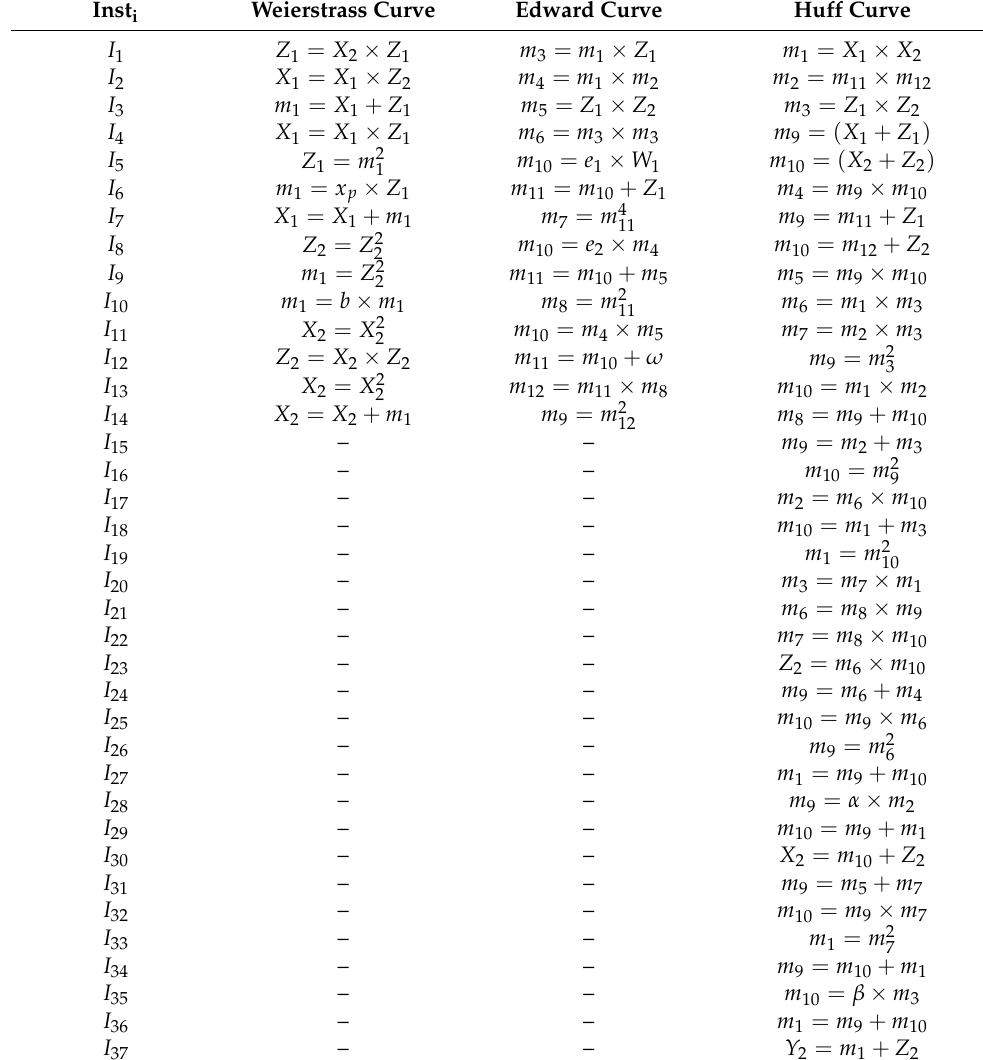
Table 2. Simplified form of a PA and PD formulations for Weierstrass, Edward and Huff curves over GF ( 2 m )